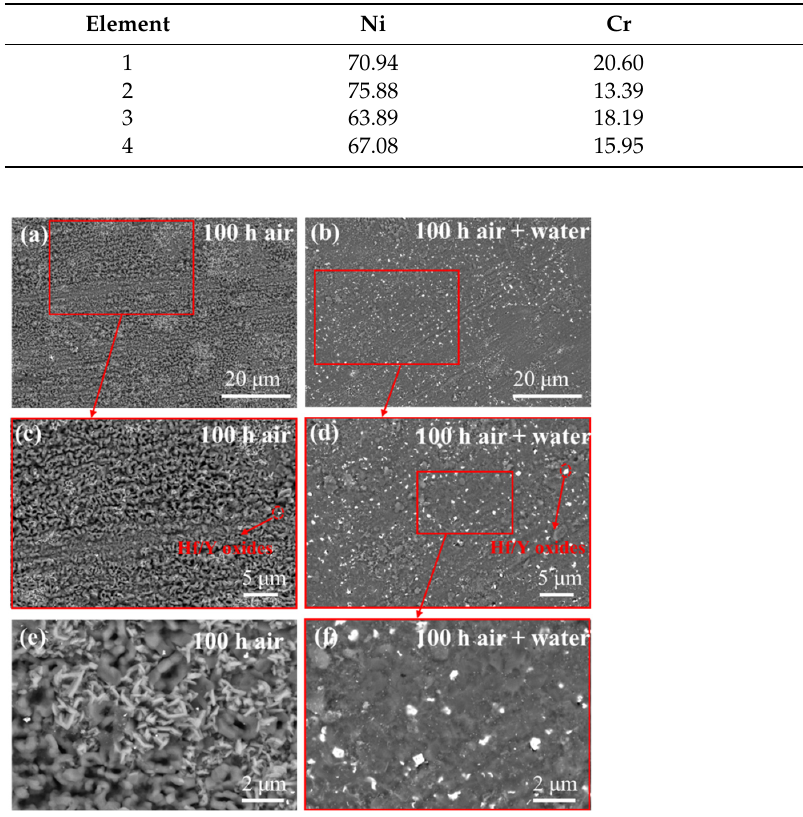
Figure 1. SEM/BSE microstructure of the as-received NiCrAlYHf alloy ( a ) and local enlarged im- age ( b ).